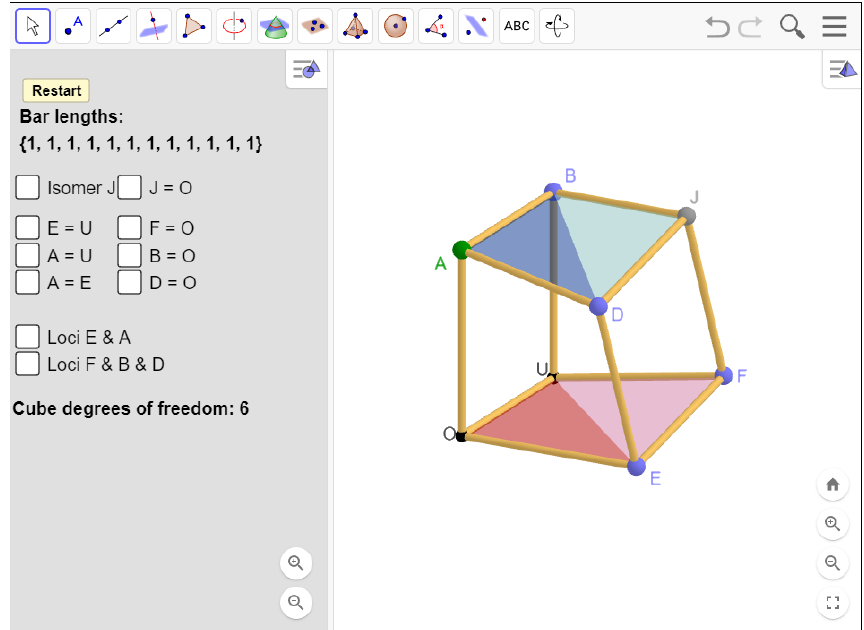
Figure 15. A GeoGebra cube with degrees of freedom O0-U0-E1-F1-A2-B1-J0-D1 with degenerate